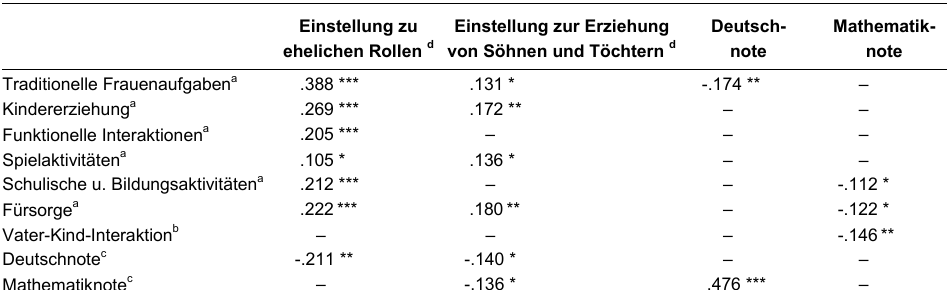
Tabelle 5: Signifikante Produkt-Moment-Korrelationen zwischen dem Geschlechtsrollenkonzept des Vaters sowie den Noten des Kindes auf dem letzten Zeugnis und der väterlichen Aufgabenübernahme und der Vater-Kind-